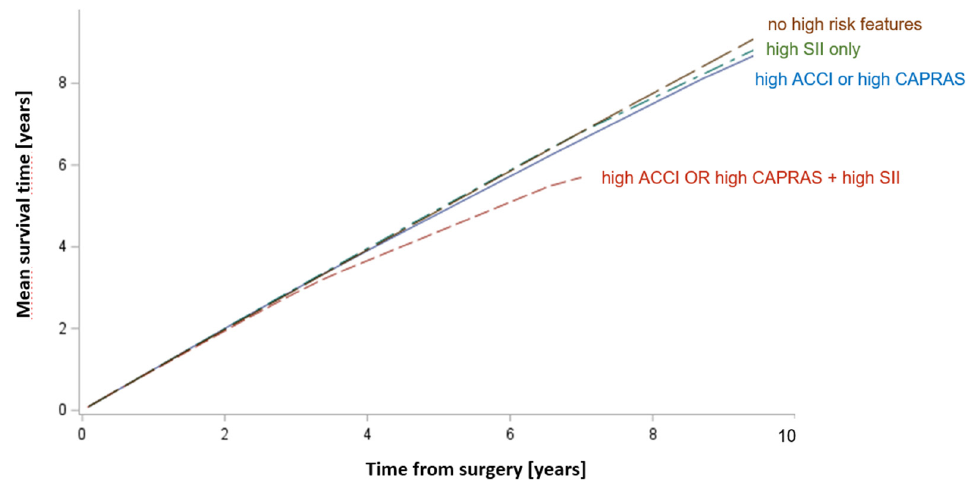
Figure 3. The mean survival time corresponding to the increasing length of follow-up among the four groups of patients.